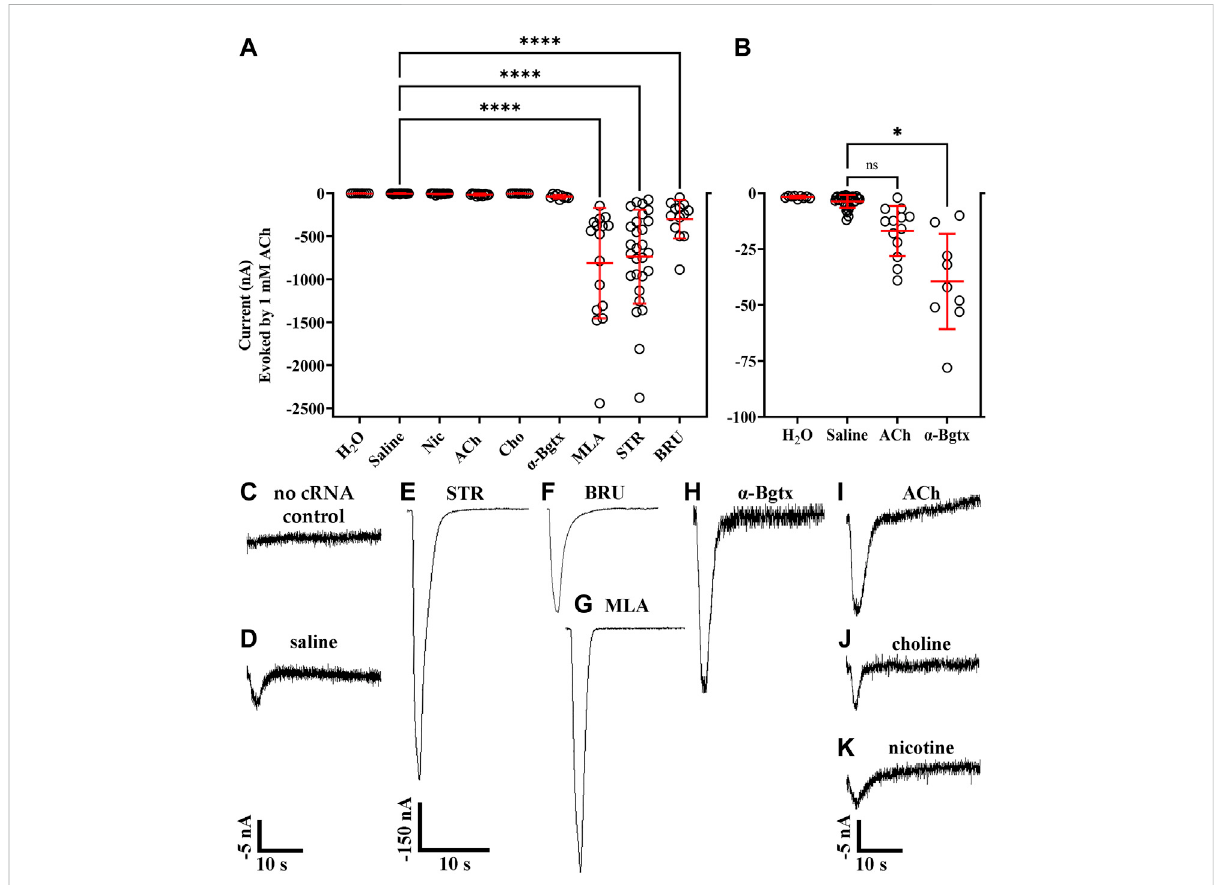
FIGURE 1 Ligand-binding promotes function of human α 10 nAChRs expressed in X. laevis oocytes. Oocytes were injected with cRNA encoding human α 10 subunits and treated for 3 days with frog saline or saline containing the indicated compounds then assessed by voltage-clamp electrophysiology for functional responses to acetylcholine (ACh; 1 mM). (A) Scatter plots of the data obtained under the indicated treatment conditions. (B) expanded data for oocytes injected with water, untreated (saline incubation only), and treated with saline containing ACh (5 mM) or α -Bgtx (1 μ M). The noise amplitude recordedfromoocytesinjectedwithwaterwas − 1.7±0.5 nA(n=9).OocytesinjectedwithwatercontainingcRNAfor α 10subunitsrespondedtoAChwith current amplitudes that were − 3.6 ± 2.8 nA (n = 32). Oocytes treated with STR (20 μ M), BRU (20 μ M) or MLA (20 μ M) responded to ACh with current amplitudes that were signi fi cantly larger than those from controls; − 735 ± 545 nA with a range of − 76 to − 2,378 nA (n = 28) for STR, − 302 ± 225 nA with a rangeof − 50to − 888 nA(n=13)forBRU,and − 813±641 nAwitharangeof − 146to − 2,443 nA(n=16)forMLA.Oocytestreatedwith α -Bgtx,ACh,Cho,or Nicwere − 39±21 nA(n=9), − 17±11 nA(n=13), − 3.7±1.5 nA(n=10),and − 6.0±6.2 nA(n=15),respectively.Currentsfromoocytestreatedwith α -Bgtx wereslightlylargerthansalinecontrols,buttherewerenosigni fi cantdifferencesincurrentamplitudesrecordedfromoocytestreatedwithACh,ChoorNic compared to saline controls. (D) Example of a current trace from a control oocyte injected with water and stimulated with ACh. (D – K) Current traces from oocytes treated with the indicated ligand. The − 5 nA scale bar applies to traces in (C,D) , and (H – K) and the − 150 nA scale bar applies to (E – G) . The “ ± ” and error bars indicate. The “ n ” indicates the number of oocytes obtained from 15